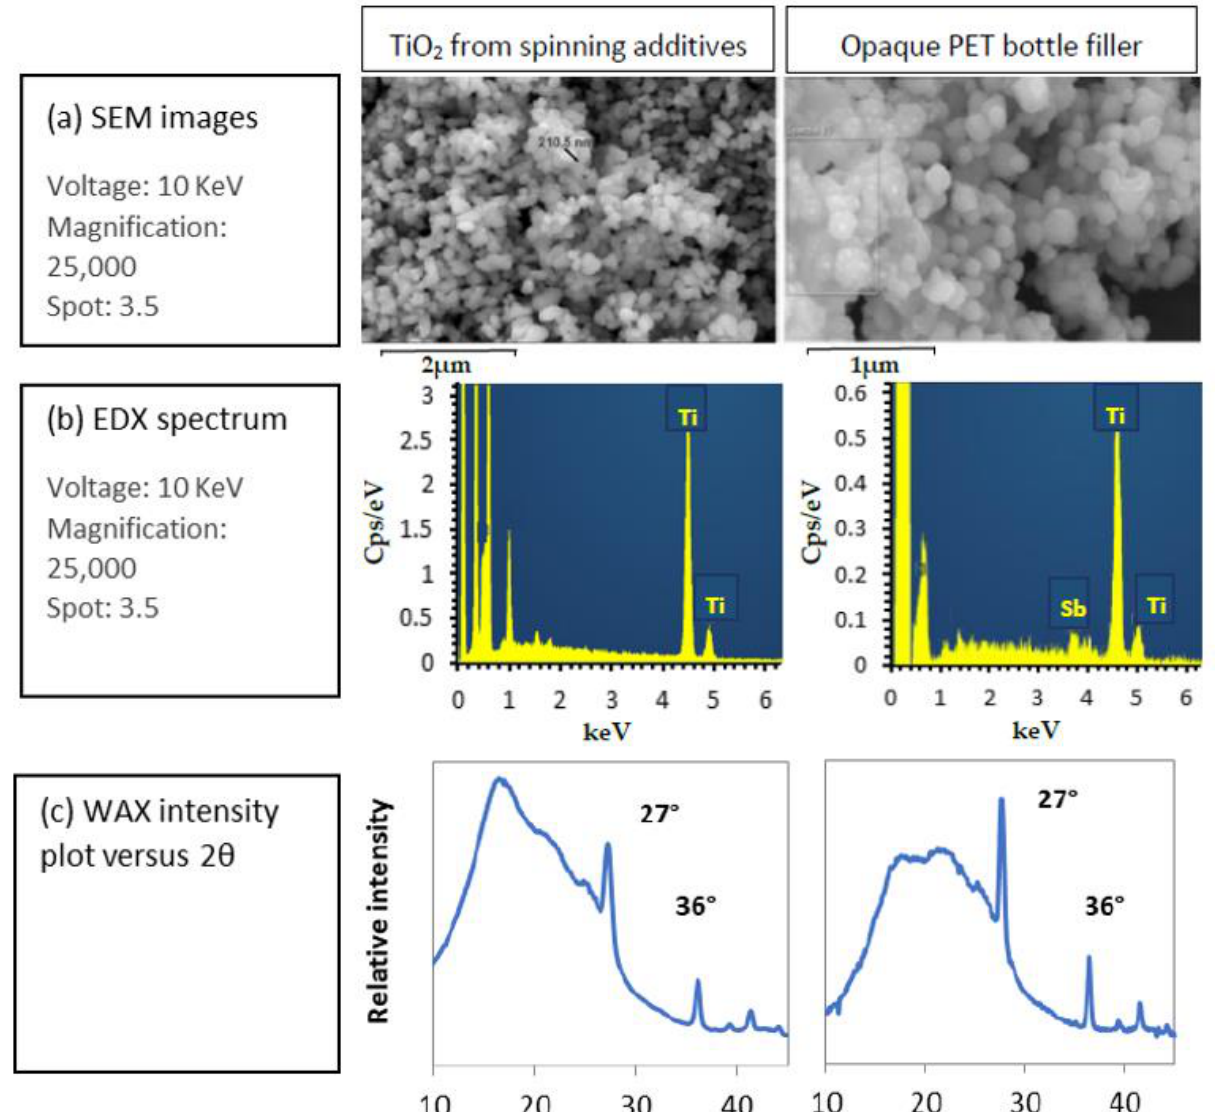
Figure 1. Characterization of TiO 2 particles from fiber industry additives ( left ) and bottle industry additives ( right ) with ( a ) SEM images, ( b ) EDX spectrum and ( c ) WAX intensity plot.